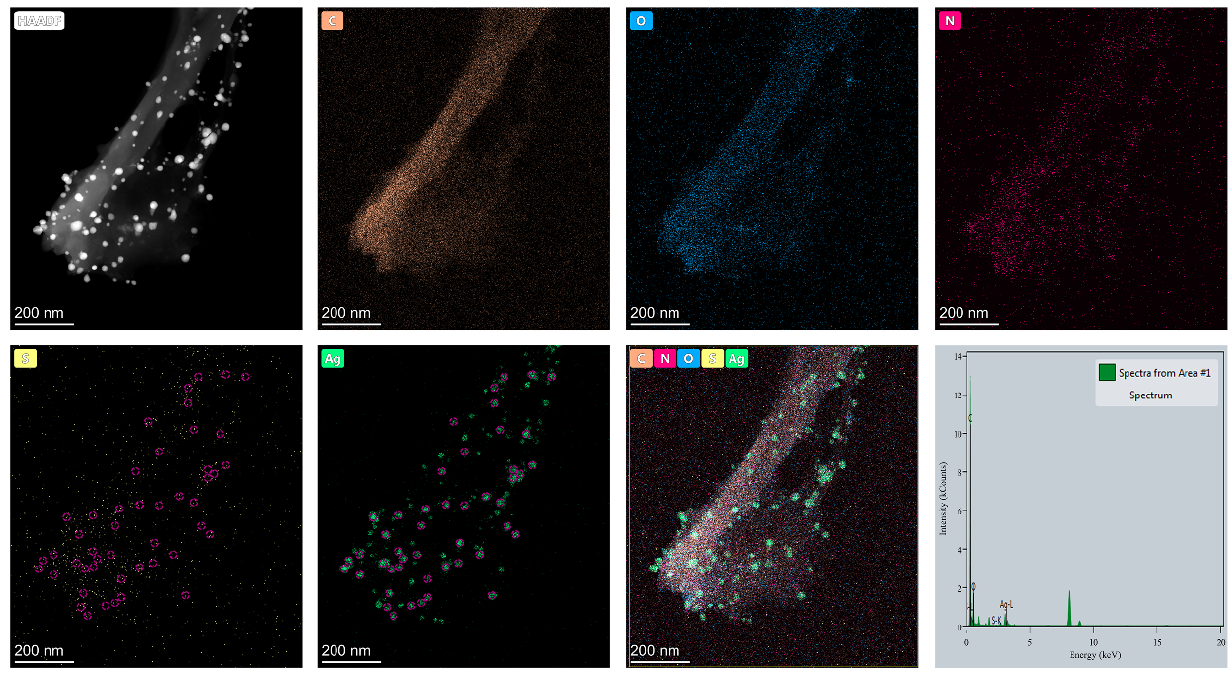
Figure 3. HAADF image, EDS mapping and an analysis of the AgNP-HHK/PEO/PVA Table 1. Element analysis of the spectra from Area #1 (Figure 3).